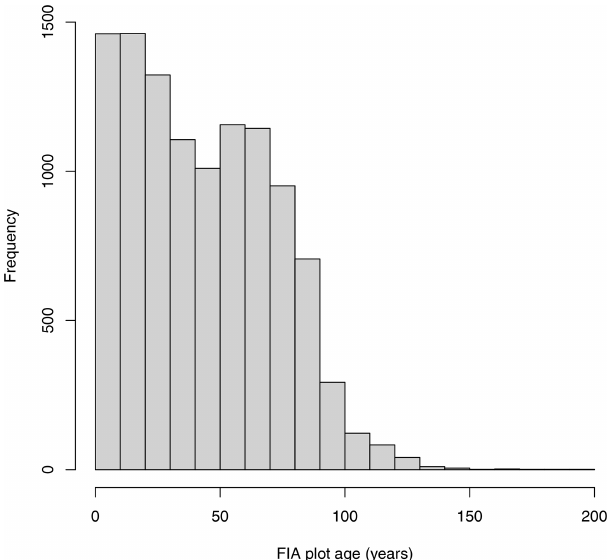
Figure D18. Histogram of FIA stand age for FIA plots in North Carolina. These distributions were used to weigh the data displayed in Figs. 2 and